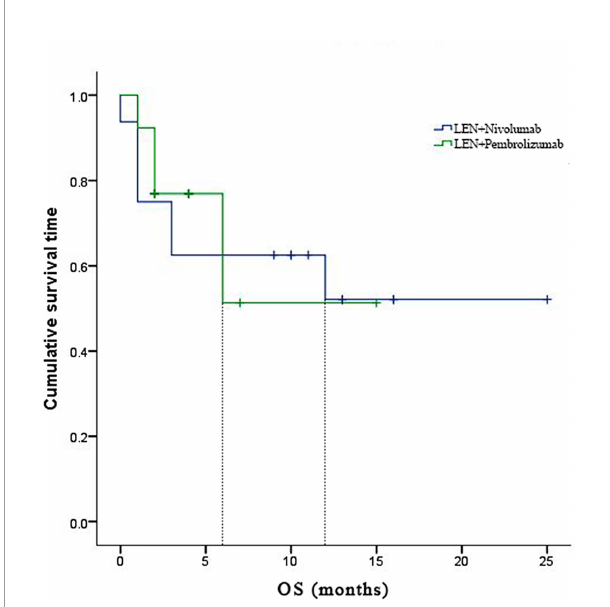
FIGURE 5 | Kaplan-Meier estimates of progression-free survival with advanced hepatocellular carcinoma who were treated with lenvatinib plus Nivolumab and pembrolizumab,